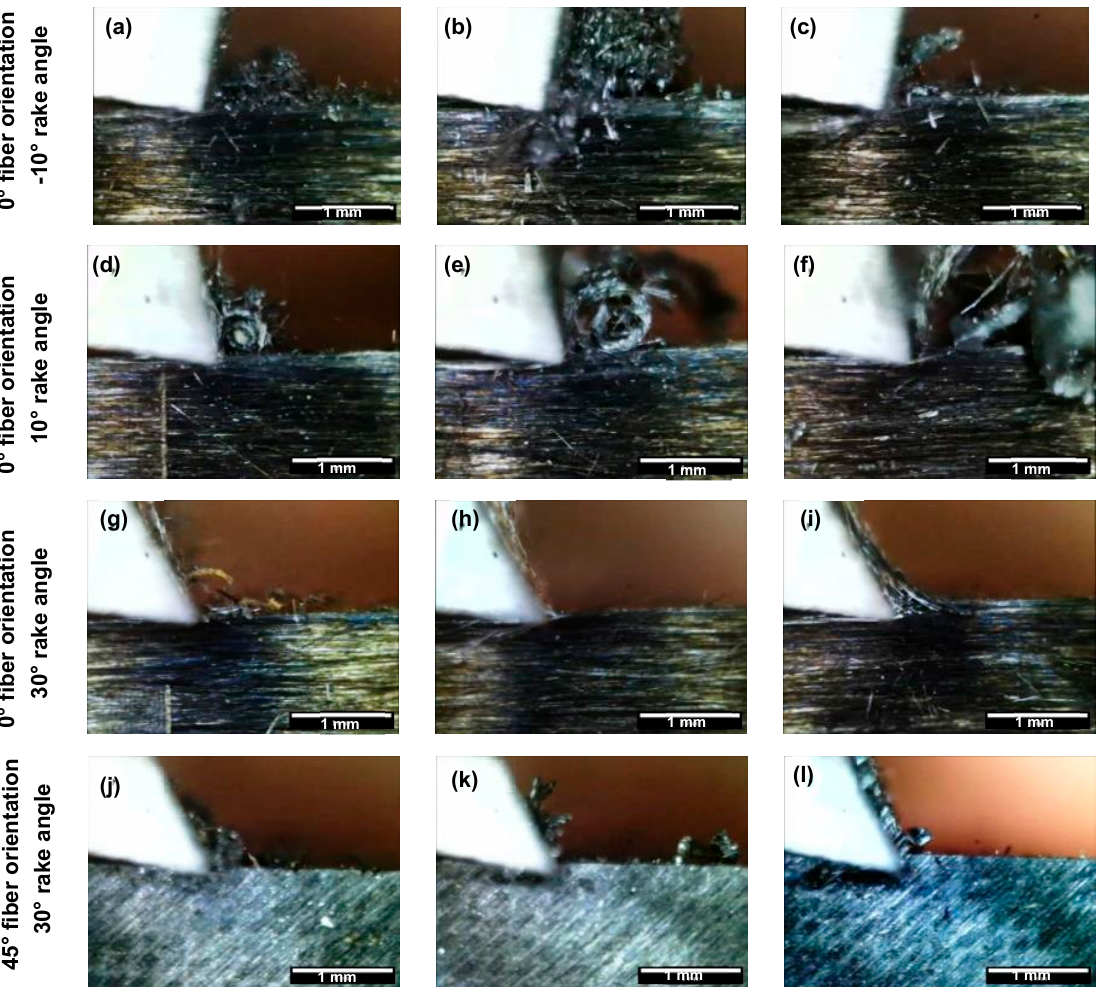
Figure 4. Chip formation at a depth of cut of ( a , d , g , j ) 50 µ m, ( b , e , h , k ) 100 µ m and ( c , f , i , l ) 150 µ m. (The white scale bar = 1mm).